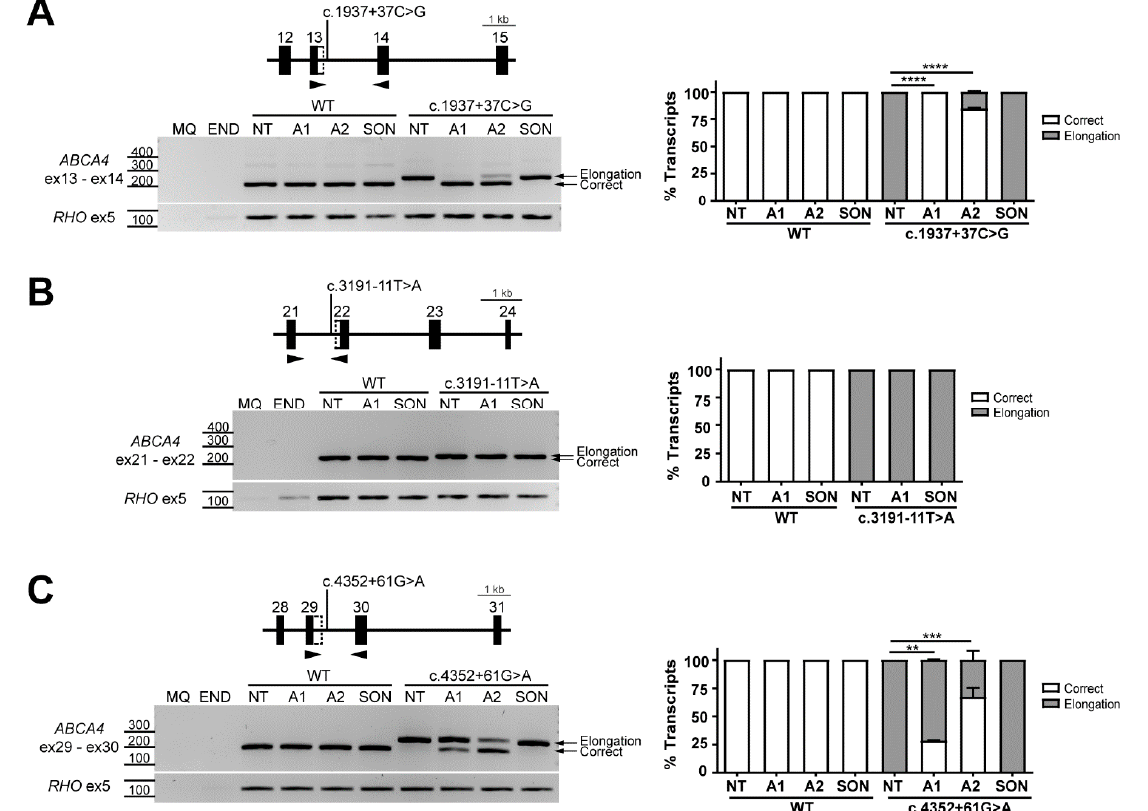
Figure 2. Antisense oligonucleotide (AON)-mediated rescue for near-exon splice variants causing exon elongation. Analysis of splicing correction by reverse transcription polymerase chain reaction (RT-PCR) upon AON (A#) delivery. Wild-type (WT) midigenes and the corresponding mutant midigenes containing near-exon variants c.1937+37C>G ( A ) c.3191-11T>A and ( B ) c.4352+61G>A ( C ) were transfected in HEK293T. Non-transfected HEK293T were used as endogenous expression control (END). The different AONs and a SON were then delivered, except for the non-treated lanes (NT). Genomic region of the different midigenes is depicted on top of each representative RT-PCR image, whereas the graphs next to each panel represent the semi-quantification of the resulting RT-PCR products, showing the percentage of correct and exon elongation transcripts. Exon elongation caused by two out of the three near-exon variants was efficiently rescued by at least one AON. MQ shows the negative control of the PCR reaction and amplification of exon 5 of the rhodopsin ( RHO ) gene was used as a transfection control. Data (n = 2) are presented as mean ± SD. Statistical significance is indicated as ** p < 0.01, *** p < 0.001 and **** p < 0.0001 using one-way